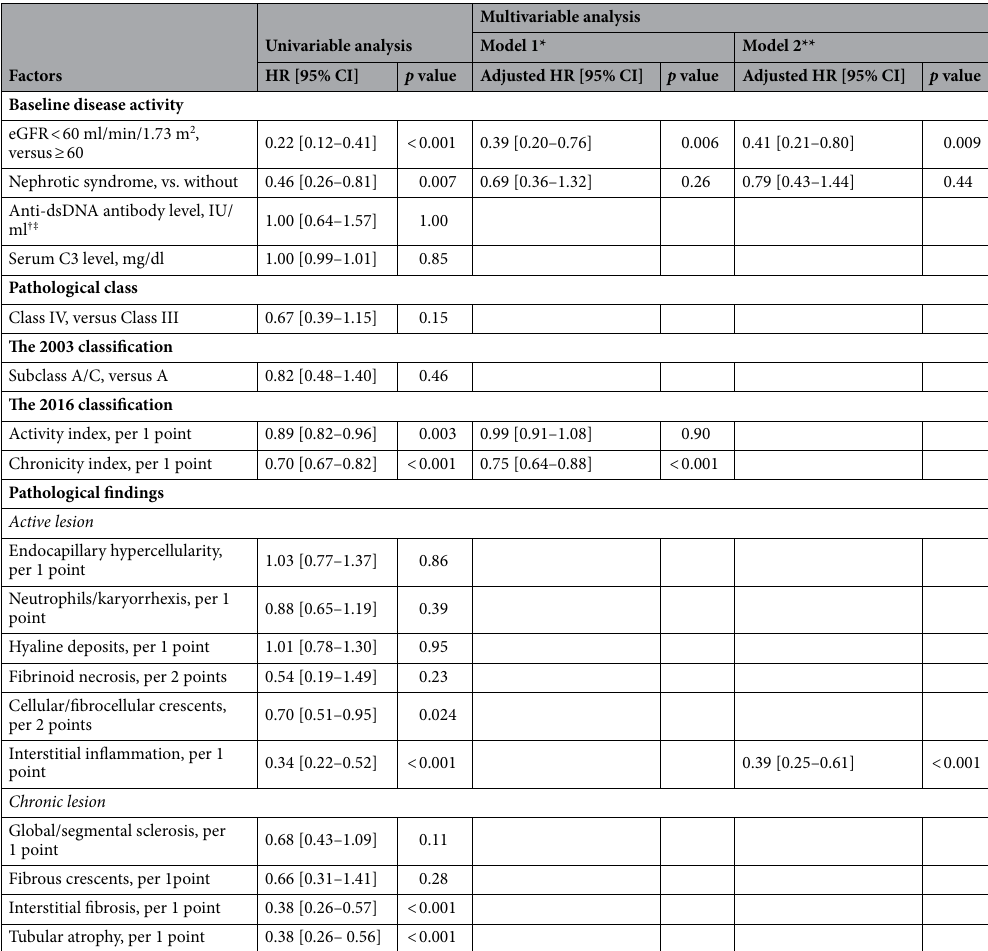
Table 5. Associated factors for complete remission. eGFR estimated glomerular filtration rate, HR hazard ratio, CI confidence interval. *Model 1 is adjusted by activity index and chronicity index by the baseline eGFR levels (cut-off of 60 ml/min/1.73 m 2 ) and the presence of nephrotic syndrome. **Model 2 is adjusted by a pathological component by eGFR and urinary protein levels. Pathological variables associated with complete remission were identified on forward–backward stepwise regression analysis. † Number of missing data: N = 29. ‡